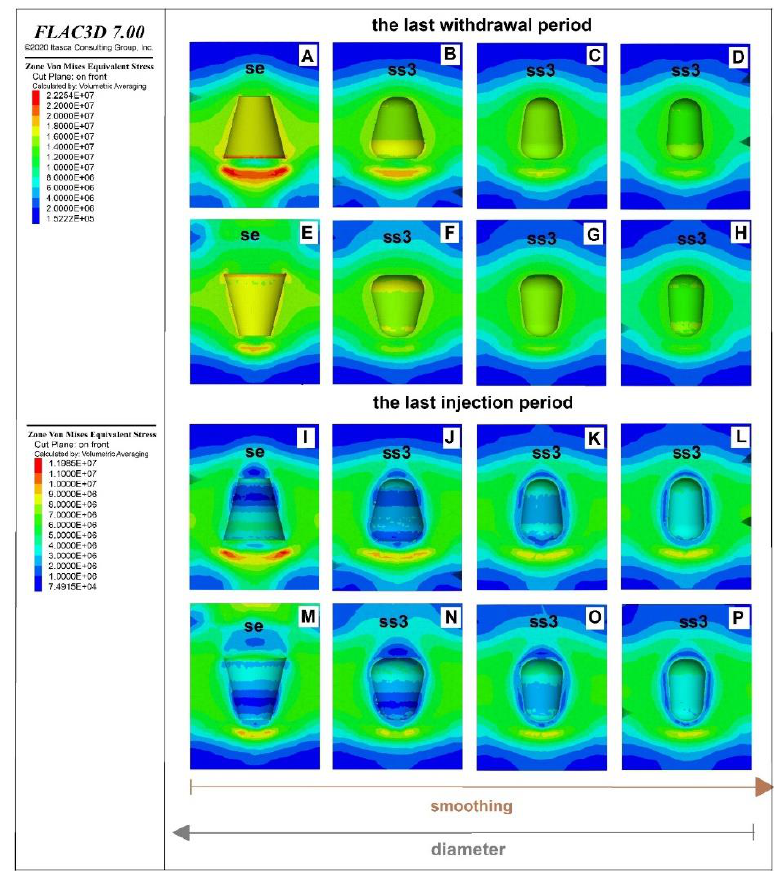
Figure 13. The vMS in the enlarged top and bottom caverns; the last cycle: ( A , E , I , M ) a maximum initial diameter of 120 m: ( A – C , E – G , I – K , M – O ) a maximum initial diameter of 90 m, ( D , H , L , P ) a maximum initial diameter of 75